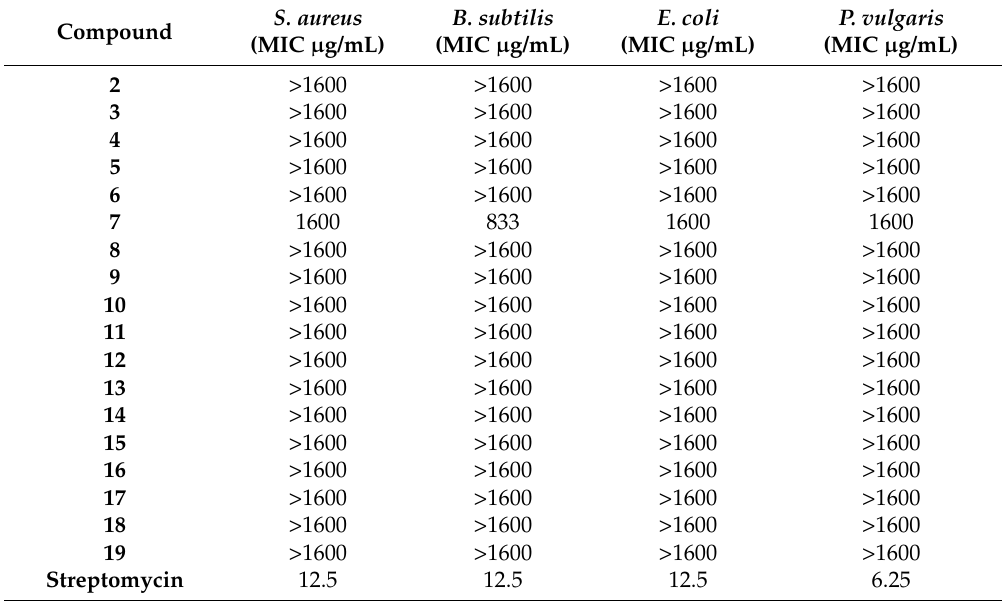
Table 2. MIC ( µ g/mL) of the compounds 2 – 19 against Gram Positive bacteria Bacillus. subtilis